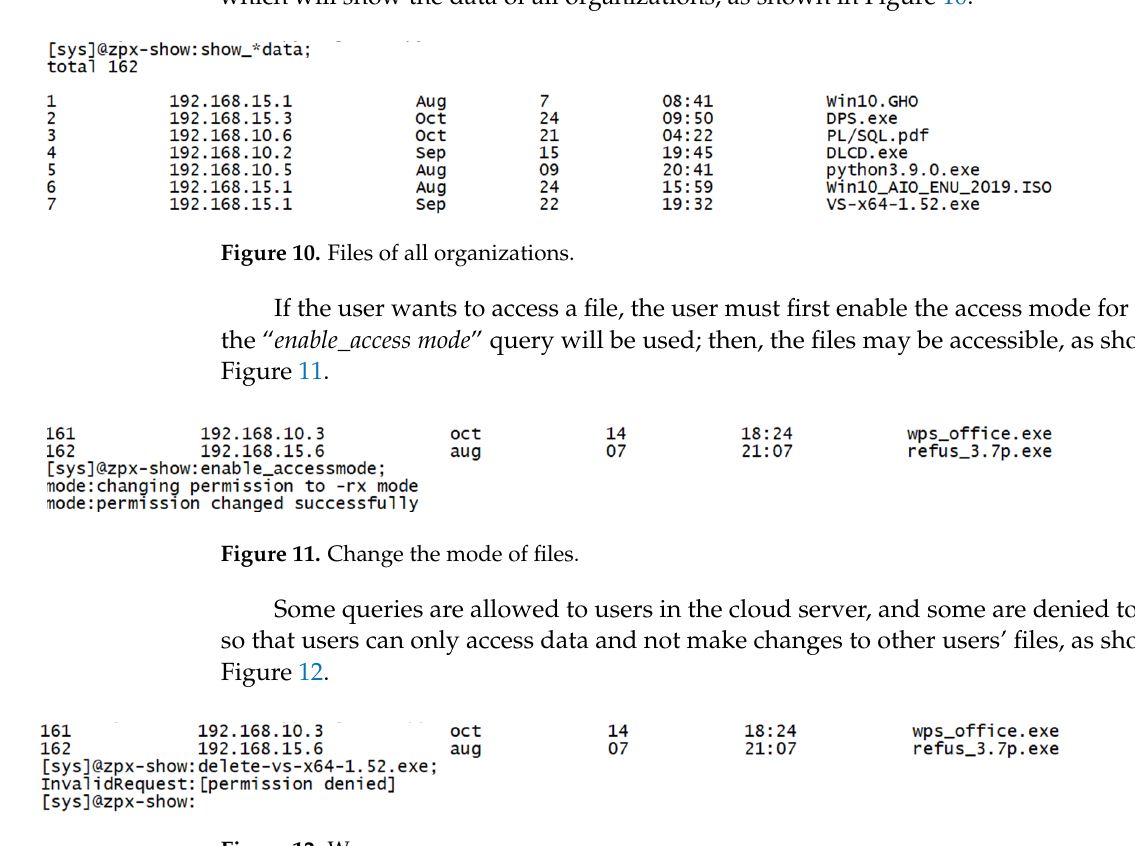
Figure 9. Exit function.